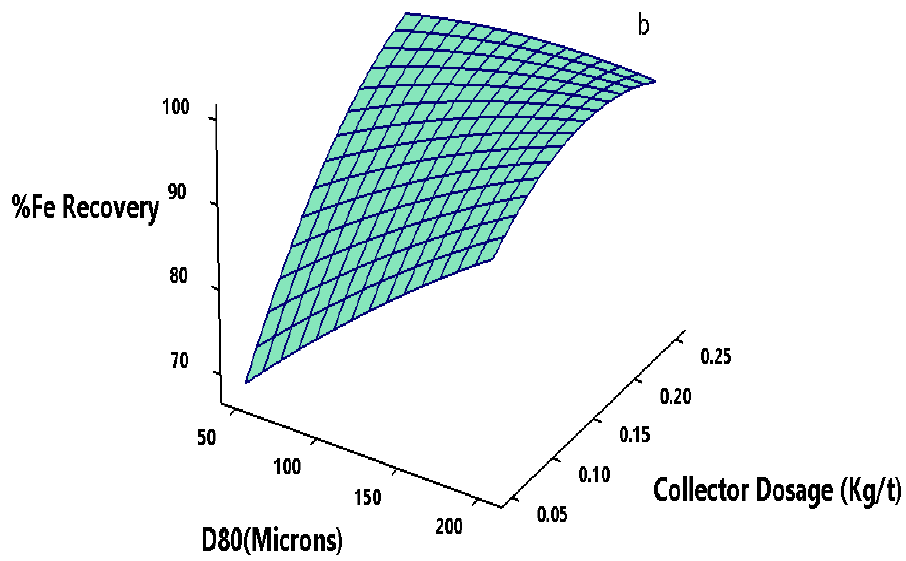
Figure 6. ( a ) Effect of collector and depressant dosages on concentrate recovery. ( b ) Effect of D80 and collector dosages on recovery of